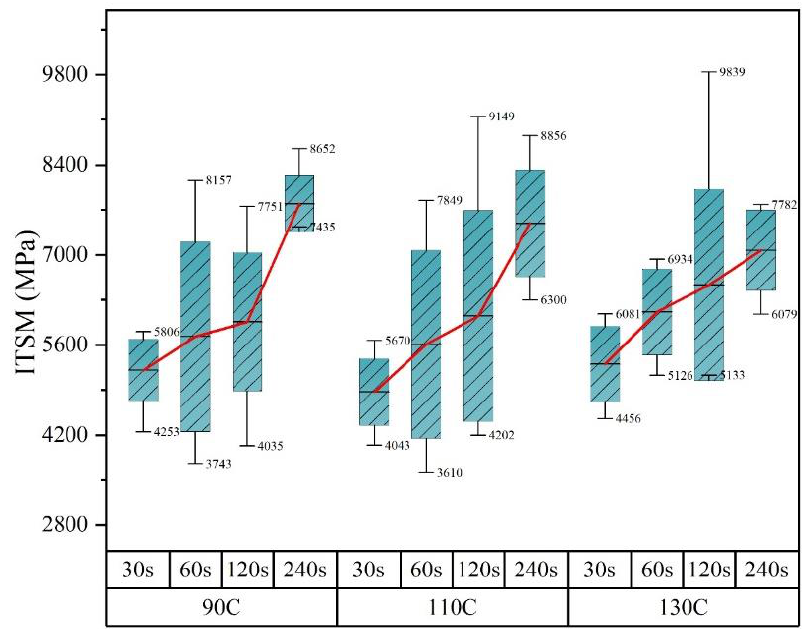
Figure 8. The stiffness values versus mixing time at different mixing temperatures.